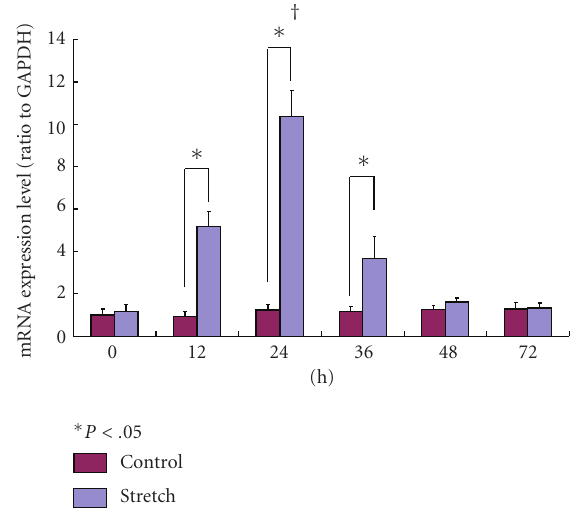
Figure 8: The expression of HSP70-mRNA in the stretching group was significantly higher than in the control group at 12, 24, and 36 hours ( P < . 05). The expression of HSP70-mRNA in the stretching group showed the highest value at 24 hours and decreased with time ( †